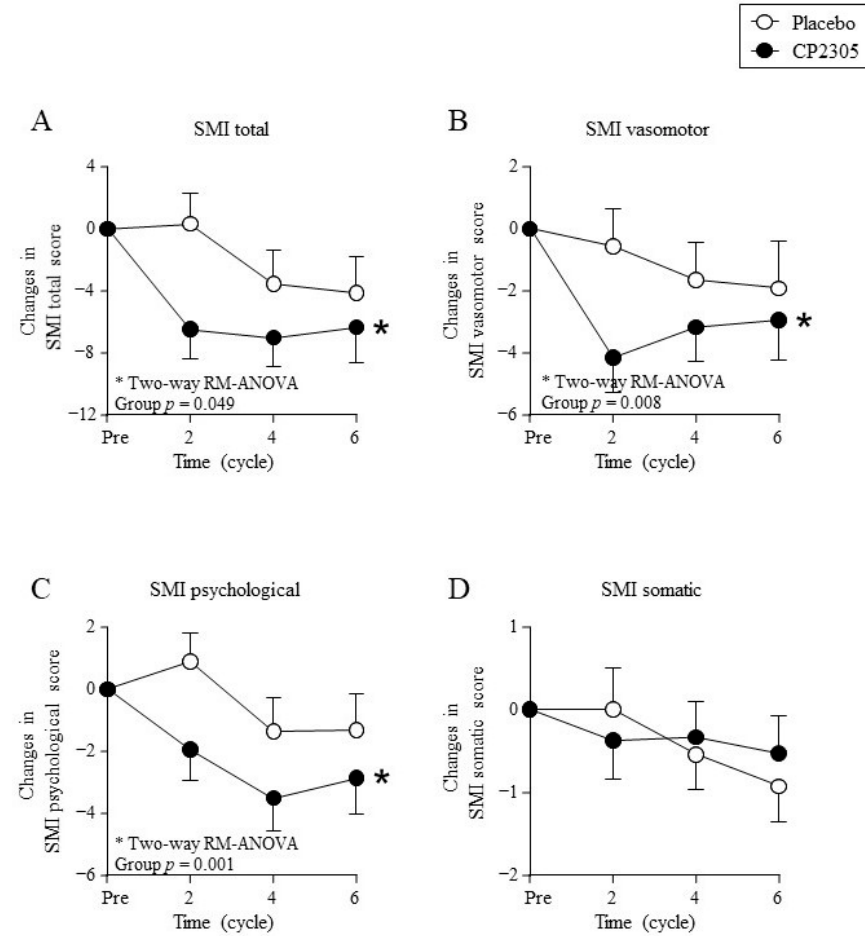
Figure 2. Changes in the Simplified Menopausal Index (SMI) during treatment. Points represent ( A ) changes in SMI total score, ( B ) changes in SMI vasomotor score, ( C ) changes in SMI psychological score, and ( D ) changes in SMI somatic score. * represents statistical difference between groups by two-way repeated measures (RM) ANOVA (detailed statistical results in Supplementary Materials Table S1). The baseline score values, post-intake score values, and percent reduction calculated using these two scores are summarized in Supplementary Materials Table S2. “Pre” indicates the values measured one-cycle before the start of ingestion.